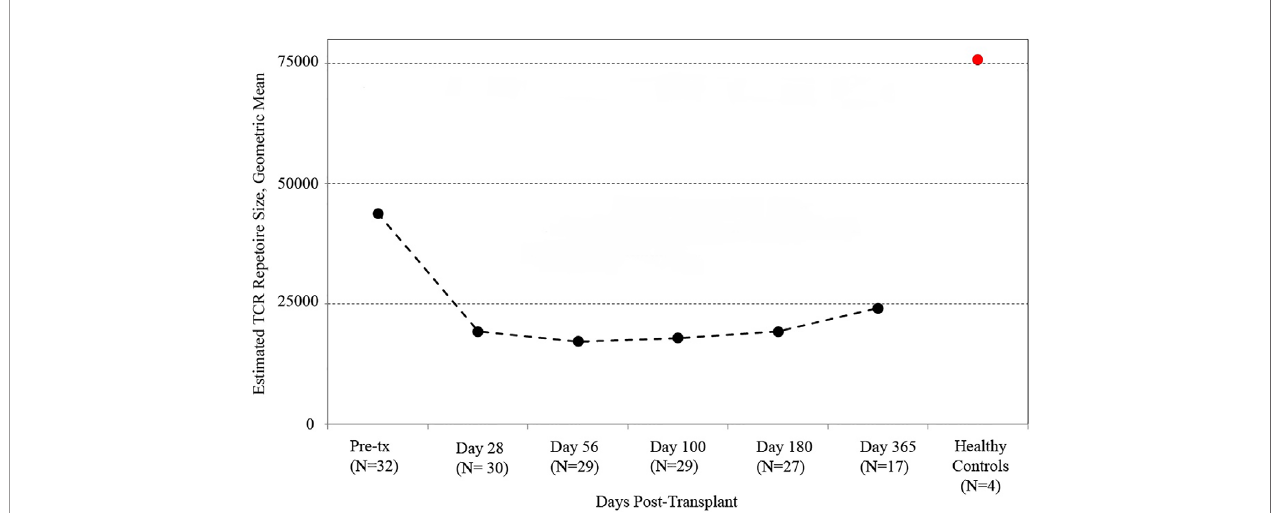
FIGURE 1 | T cell receptor (TCR) repertoire reconstitution after stem cell transplant. We obtained peripheral blood samples from each of 32 patients before transplant and fi ve times after transplant. TCR repertoire size for each patient was estimated using high-throughput sequencing of TCR rearrangements, and the geometric mean of estimated TCR repertoire size is shown. After transplant, patients had a vastly reduced TCR repertoire which reached its minimum 56 days posttransplant before beginning a slow recovery. The value for healthy subjects is the geometric mean of sixteen samples (four samples per subject from four healthy